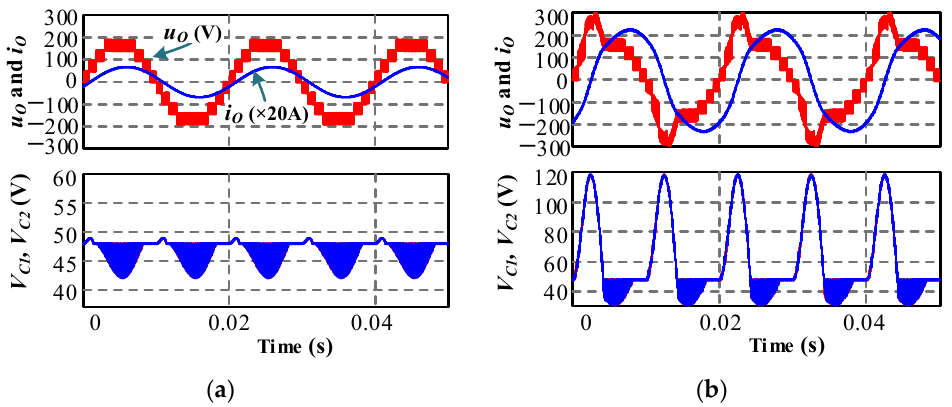
Figure 10. Simulation waveforms for the original inverter with inductive loads: ( a ) 50 Ω -50 mH; ( b ) 10 Ω -50 mH.